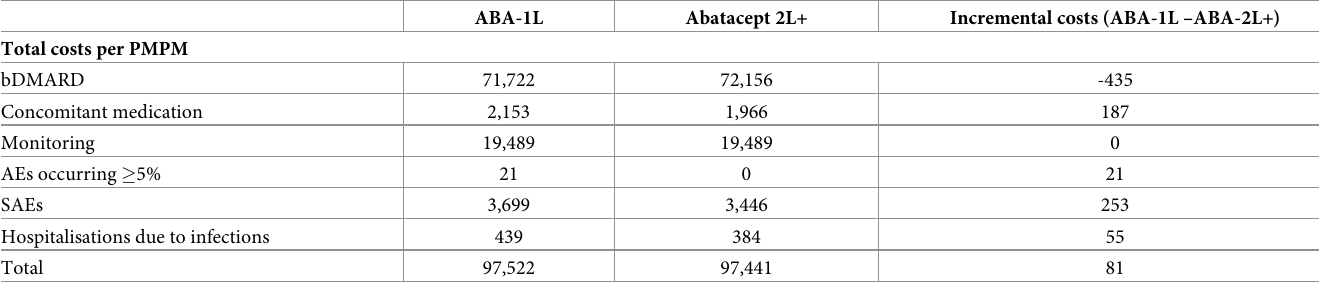
Table 8. Cost results breakdown–per member per month (ABA-1L vs. ABA-2L+).